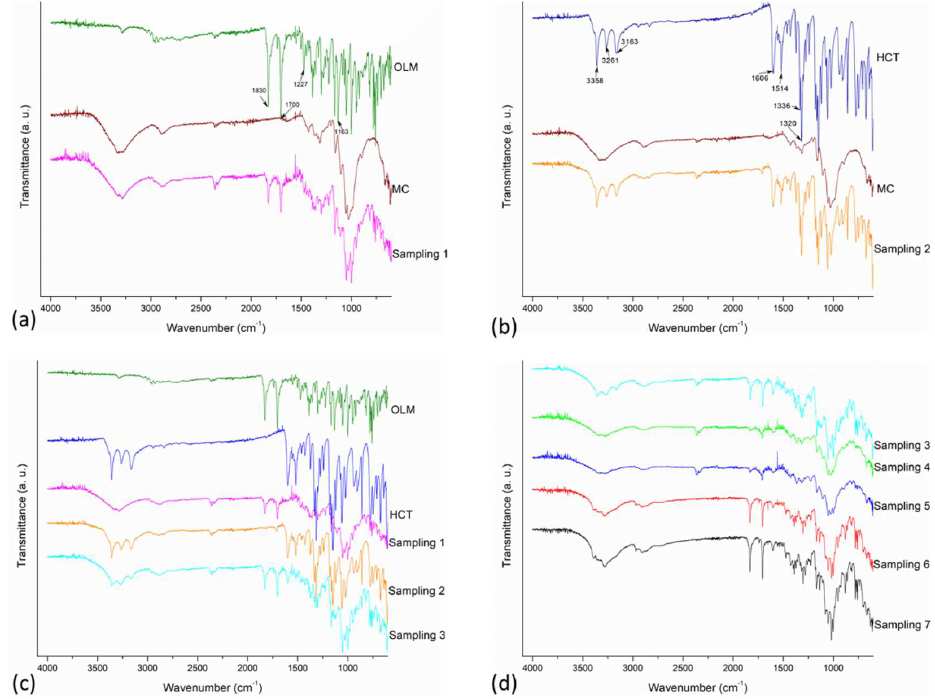
Figure 4. FT-IR spectra of each sampling of F 1 : ( a ) OLM and sampling 1 (i.e., OLM + MC), ( b ) HCT and sampling 2 (i.e., HCT + MC), ( c ) OLM, HCT, and sampling 3 (i.e., sampling 1 + 2), ( d ) Sampling 3 and samplings from 4 to 7.